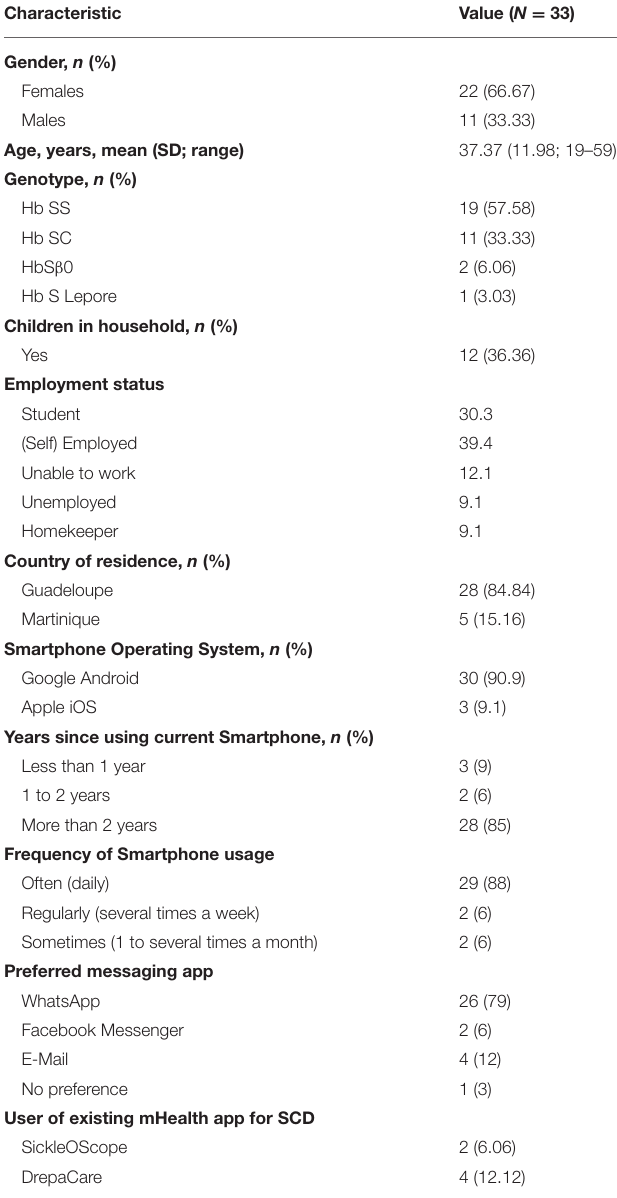
TABLE 3 | Characteristics of the study